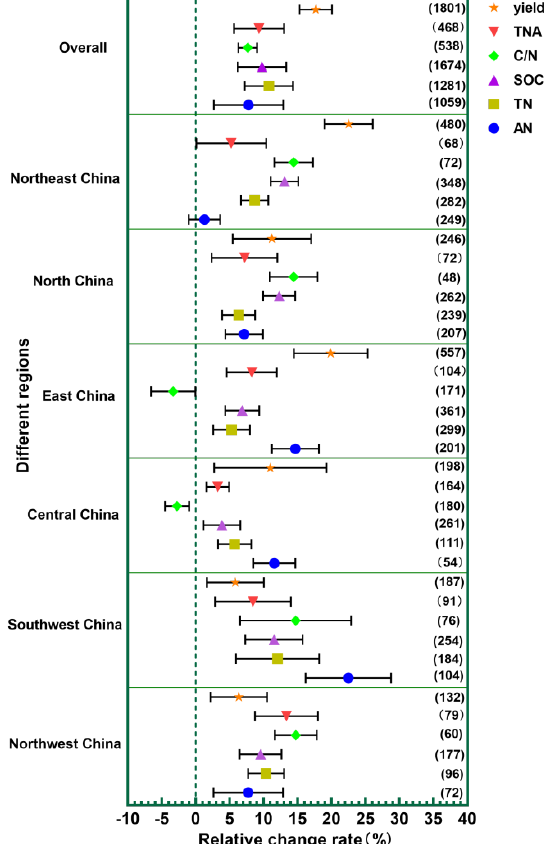
Figure 3. Relative change rates for different rice planting regions in China. Description of symbols: AN, soil alkaline-hydrolysable nitrogen; TN, soil total nitrogen; SOC, soil organic matter; C:N, soil carbon–nitrogen ratio. Numbers in parentheses represent the effect value